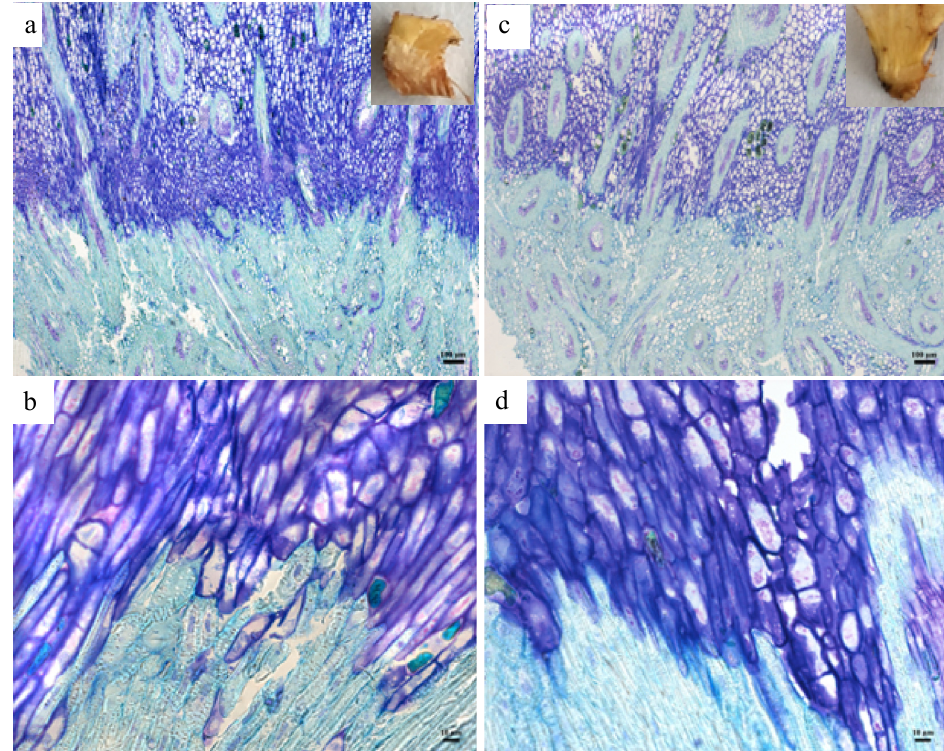
Figure 3. Comparison of the shedding and non-shedding fruit bases. ( a ) Base of fruit of normal shedding fruit. ( b ) Higher magnification of the fruit base from a normal shedding fruit. ( c ) Fruit base from the non-shedding fruit. ( d ) Higher magnification of base of fruit from a non-shedding fruit. Longitudinal sections were stained with toluidine blue. Mesocarp cells situated above the pedicel stained darker blue. The photos shown are representative of at least 6 replicate fruit bases examined.